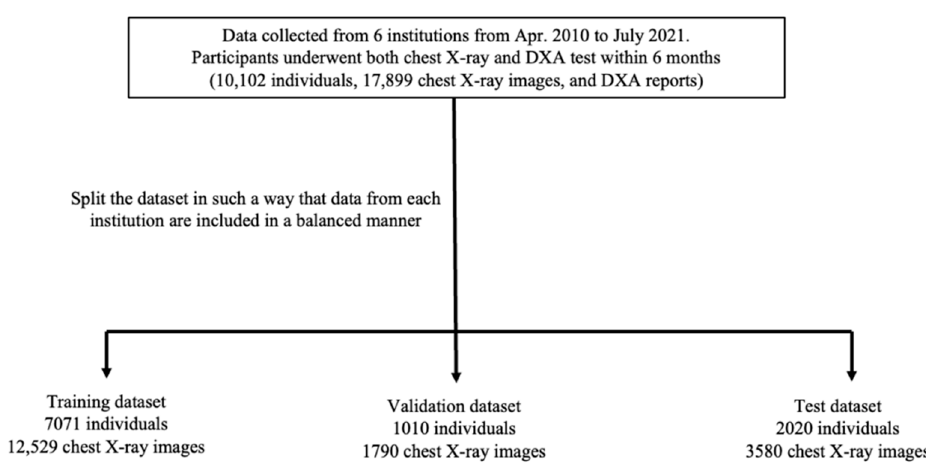
Figure 1. Dataset configuration. Note: DXA: dual-energy X-ray absorptiometry.